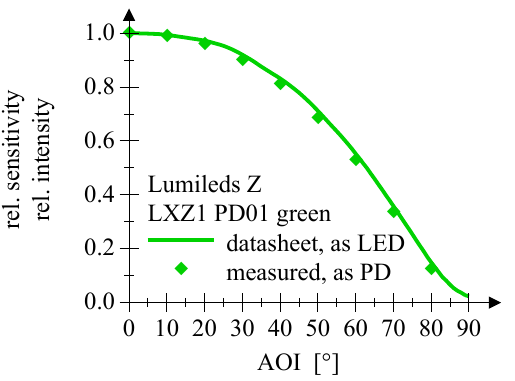
Figure 14. This plot shows the AOI comparing datasheet values and measured PD employment of a green Lumileds Z LED.